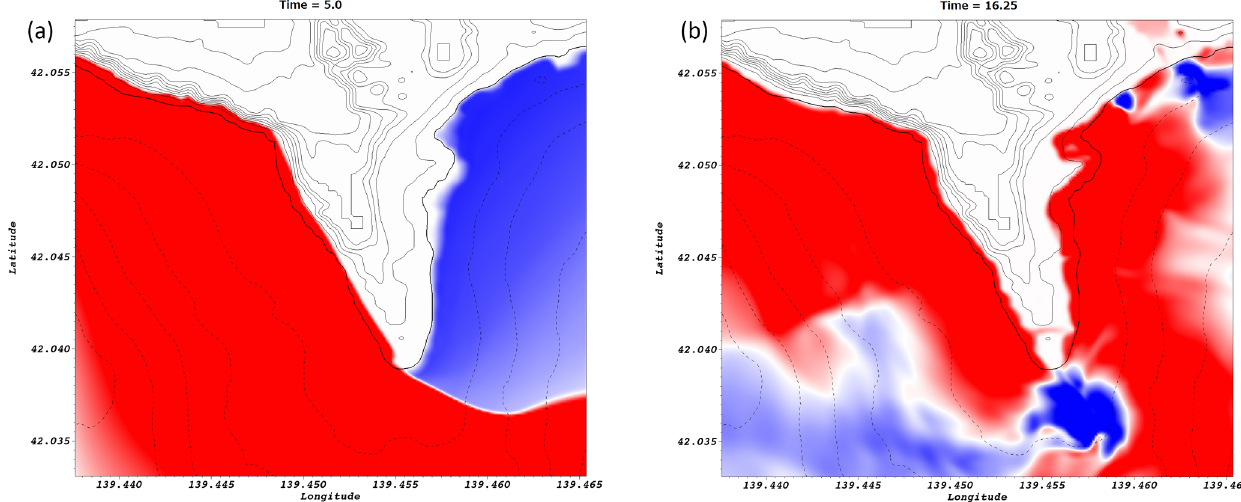
Figure 21. Two waves arriving at Aonae peninsula. (a) First wave coming from the west arrived at around t = 5min. (b) Second wave coming from the east arrived at around t = 16min.